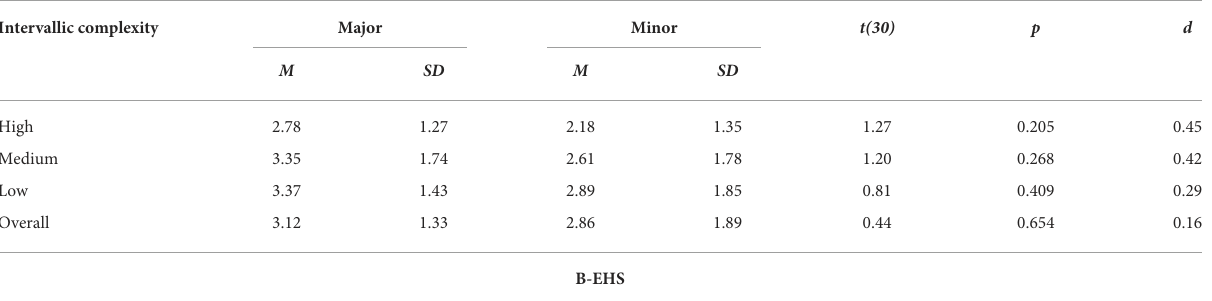
TABLE 3 Means and standard deviations of three dependent variables for an efficiency of visuo-motor coordination, as well as results of bootstrap t -tests with Bonferroni’s correction ( subset α = 0.025) for effects of modality on each measure. Intervallic